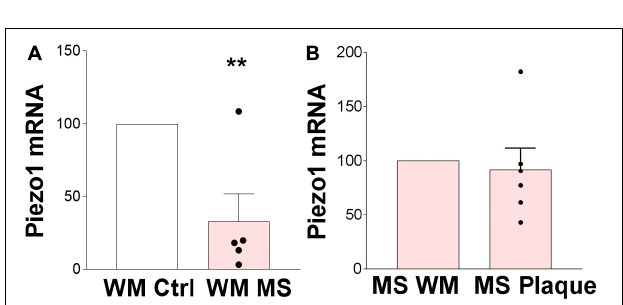
FIGURE 5 | Piezo1 expression is downregulated in MS brain. (A) Analysis of Piezo1 mRNA levels shows significantly reduced expression of Piezo1 in MS brain in white matter (WM) (32.7 ± 19.2% vs. ctrl). Unpaired Student’s t -tests, ** p < 0.005, N = 2 ctrl and N = 5 MS brains. (B) No differences in Piezo1 expression were found in the MS brains between WM lesions (plaques) and lesion-free WM within the same MS brain (91.98 ± 19.77% plaque vs. WM). Unpaired Student’s t -tests, p > 0.05, N = 5 MS